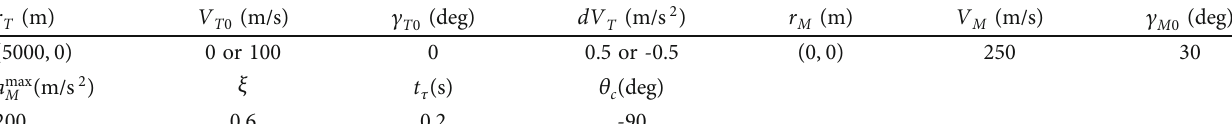
Table 8: Simulation conditions for Case